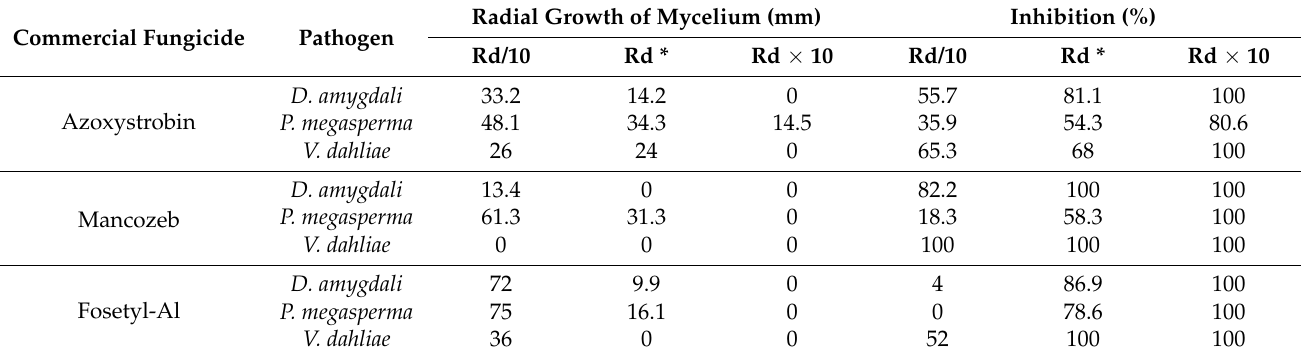
Table 3. Radial growth of mycelium of D. amygdali, P. megasperma , and V. dahliae in in vitro assays performed on a PDA medium amended with different concentrations (the recommended dose, 1/10th of the recommended dose, and 10 times the recommended dose) of three commercial synthetic